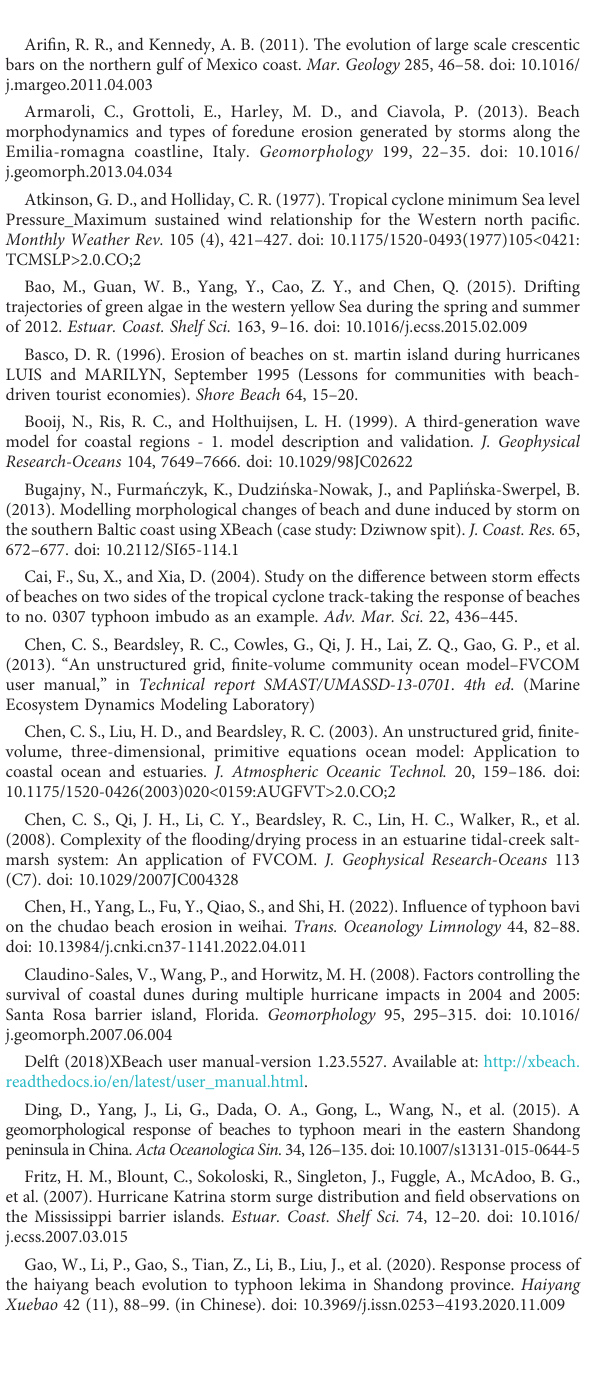
SUPPLEMENTARY FIGURE 3 Comparisons between the observed and simulated water levels at Station T (A) , signi fi cant wave heights (D) and peak wave periods (G) at Station W, respectively (red and black lines indicate the observed and simulated results, respectively). The middle (B, E, H) and right (C, F, I) columns show the comparisons of surface current velocities and directions at Stations C1, C2 and C3, respectively (observed results are shown in red dots and simulated results are indicated by black lines).